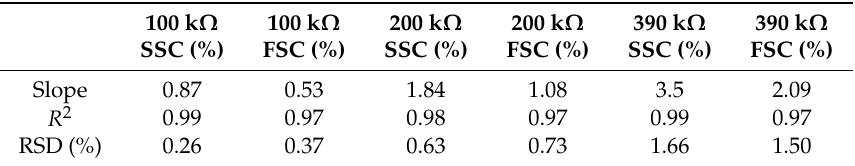
Table 4. Summary of the measured SSCs and RSCs of R6G labeled HeLa cells using load resistors at different concentrations with #369 excitation filter (470 nm) and #389 emission filter (500 nm), n = 12/cell numbers.